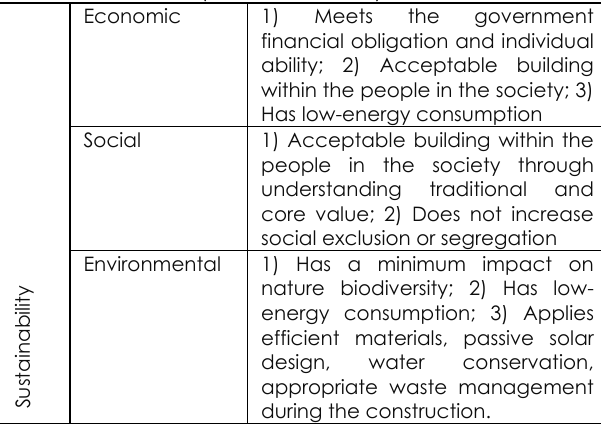
Table 2. The characteristic of sustainable housing according to literature review. (Pullen et al., 2010)